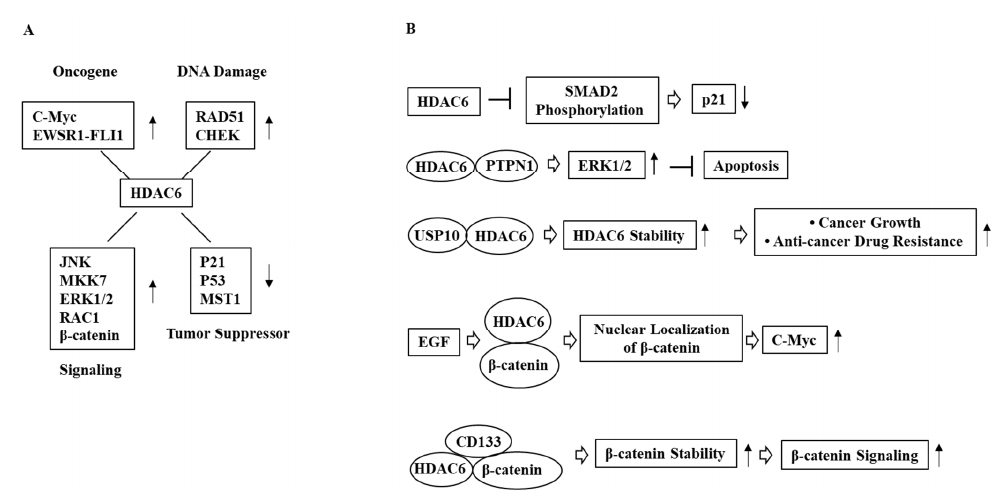
Figure 2. Mechanism of HDAC6 ‐ promoted cancer cell proliferation. ( A ) Genes and signaling pathways regulated by HDAC6. ( B ) HDAC6 decreases the expression of p21 to promote cancer cell proliferation. USP10 increases HDAC6 stability, which in turn promotes cancer cell proliferation. HDAC6 enhances β‐ catenin signaling to promote cancer cell proliferation. HDAC6 binds to PTPN1, which activates ERK signaling and promotes cancer cell proliferation. ↓ denotes negative regulation; ↑ denotes positive regulation; T bar arrows denote negative regulation; and hollow arrows denote direction of reaction.